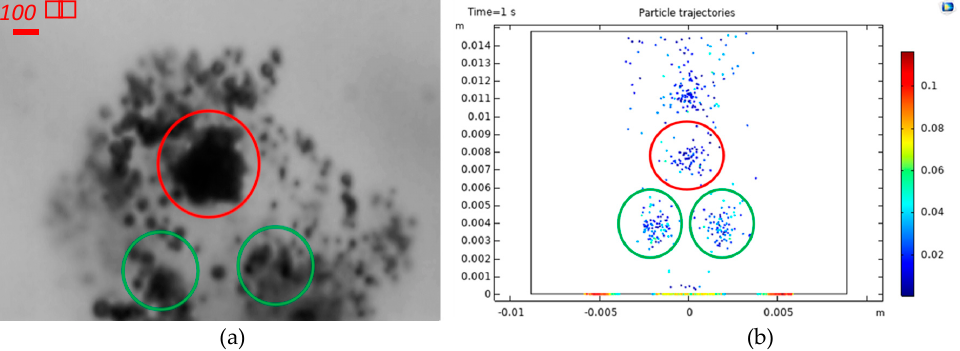
Figure 7. Bubble cloud formation ( a ) experimental results ( b ) numerical results for the response of air particles to the applied acoustic